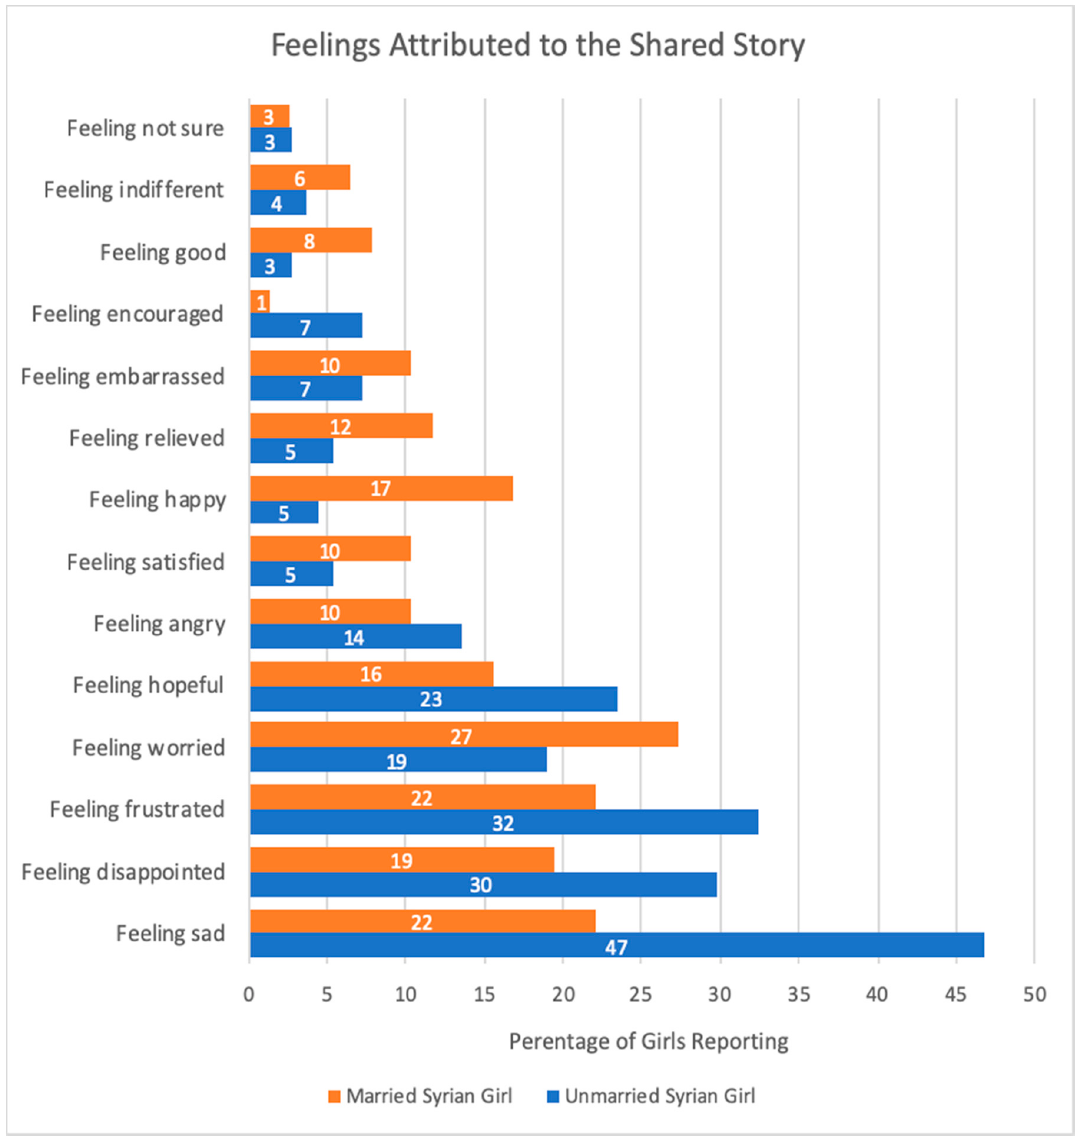
Figure 1. Proportion of married ( n = 77) and unmarried ( n = 111) girls who self-reported specific feelings attributed to the story they shared. The question was “how does the story make you feel?”